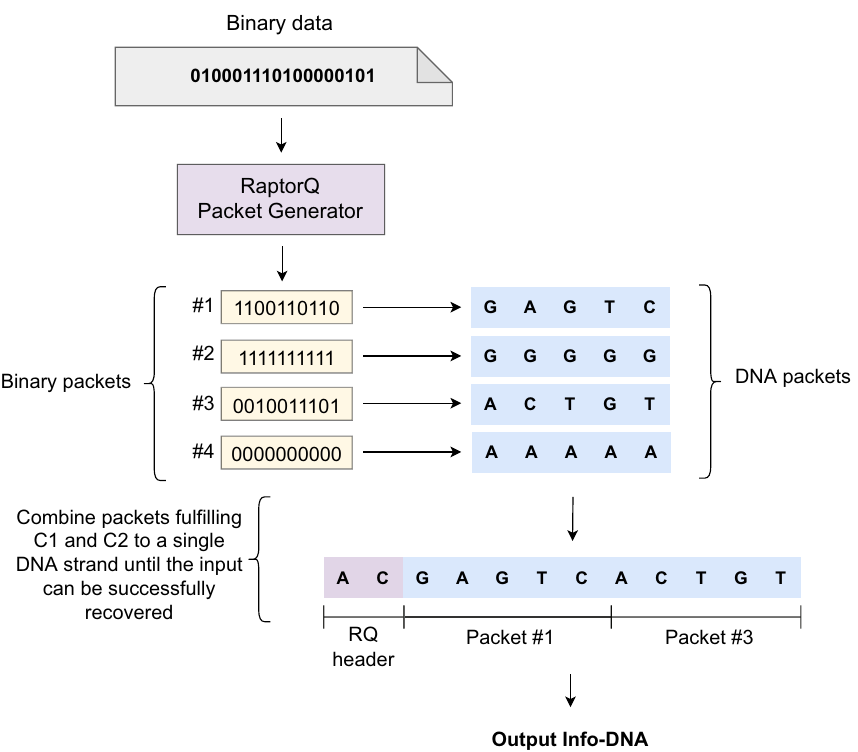
Figure 5. Encoding information with RaptorQ